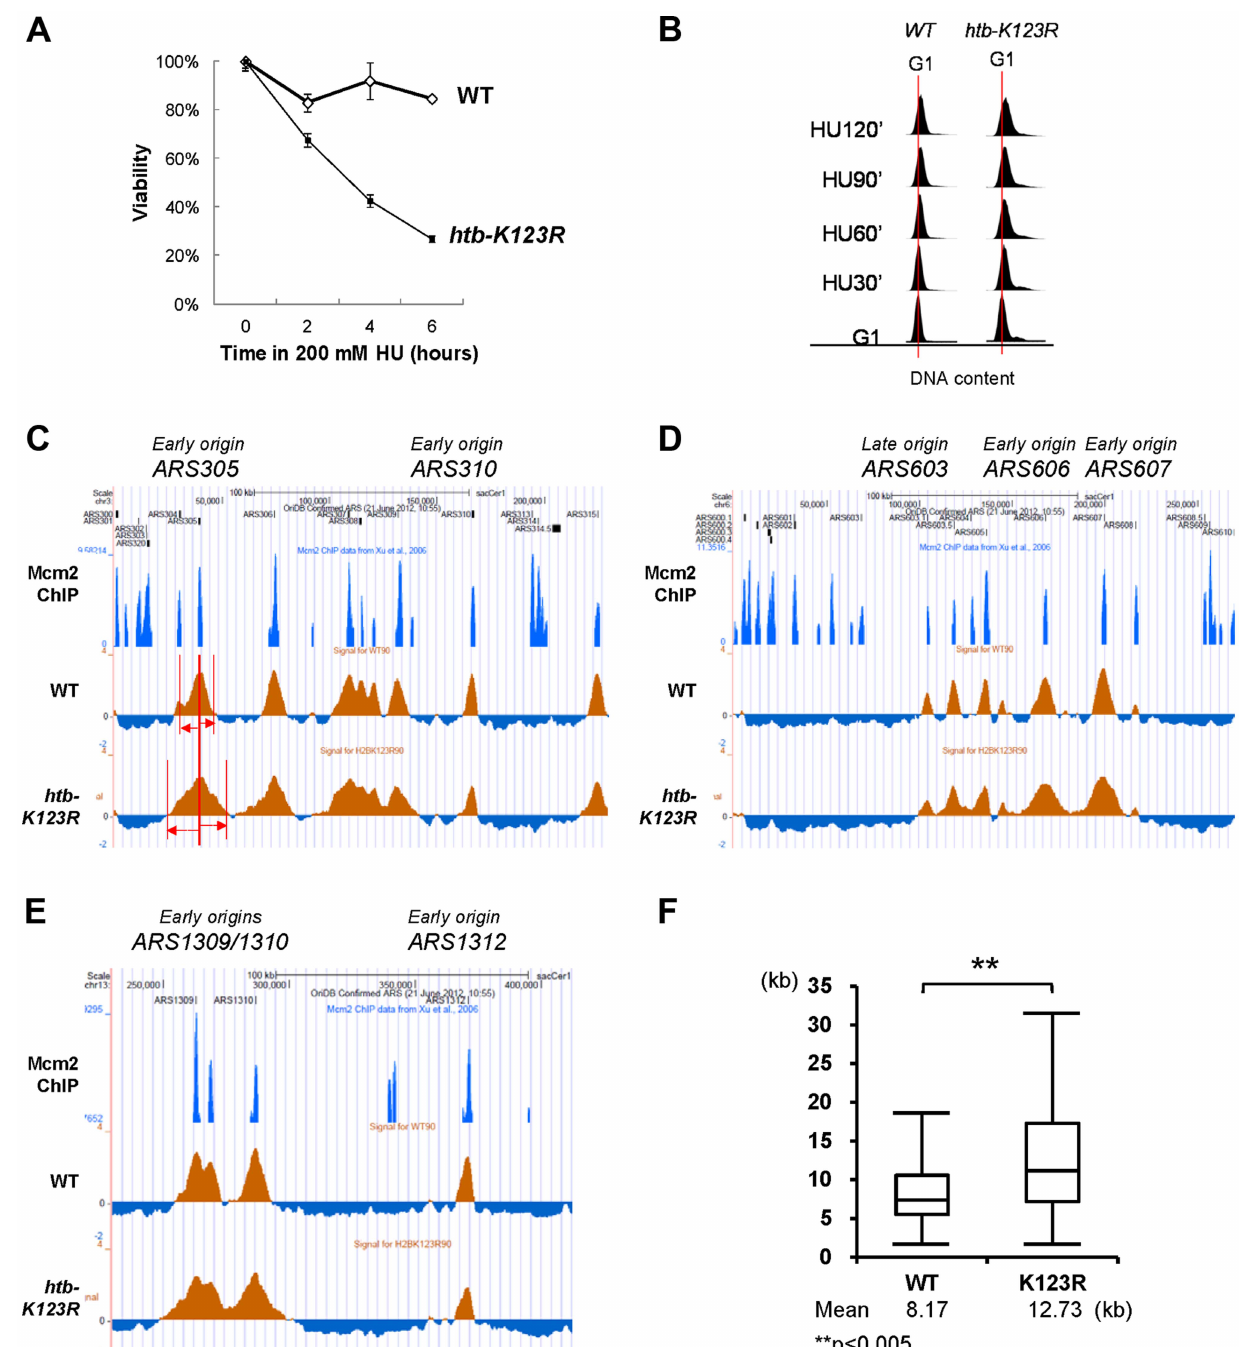
Figure 1. H2Bub regulates fork stalling in HU. (A) The response of WT (CFK1204) and htb-K123R (CFK1231) cells to acute doses of HU. Log-phase cells were treated with 0.2M HU for the indicated times, and dilutions were subsequently spread onto YPD plates. The plates were incubated at 30 u C for 2–3 days and viability was estimated based on colony forming units (CFU). Viability was normalized to 0 min of HU treatment, which was set as 100%. (B) Flow cytometry was used to analyze the cell cycle progression of WT (CFK1204) and htb-K123R (CFK1231) cells in the presence of 0.2M HU for 120 minutes after release from a -factor-induced G1 arrest. DNA content is visualized by propidium iodide incorporation. (C–E) Replication profiles of replication origins: (C) ARS305 and ARS310 , (D) ARS603 , ARS606 , and ARS607 , and (E) ARS1309/1310 and ARS1312 , in WT (CFK1419) and htb-K123R (CFK1421) cells. Cells were synchronized in G1 with a -factor, and then released into media containing 0.2M HU and 200 m g/ml BrdU for 90 minutes. After DNA extraction and fragmentation, BrdU-labeled DNA was immunoprecipitated and hybridized on high-resolution oligonucleotide tiling arrays. Orange histogram bars (BrdU) on the y axis represent the average signal ratio on a log2 scale of loci along the reported regions. Positions of ARS elements are identified by Mcm2 occupancy [72]. (F) The graph depicts the distribution of BrdU track lengths in WT (CFK1419) and htb-K123R (CFK1421) cells. Box and whiskers indicate the minimum, maximum, and 25–75 percentiles, respectively. Mean BrdU tracks lengths are indicated in kb. Asterisks indicate the P-value of the statistical test (Mann–Whitney rank sum t-test, ** P-value ,